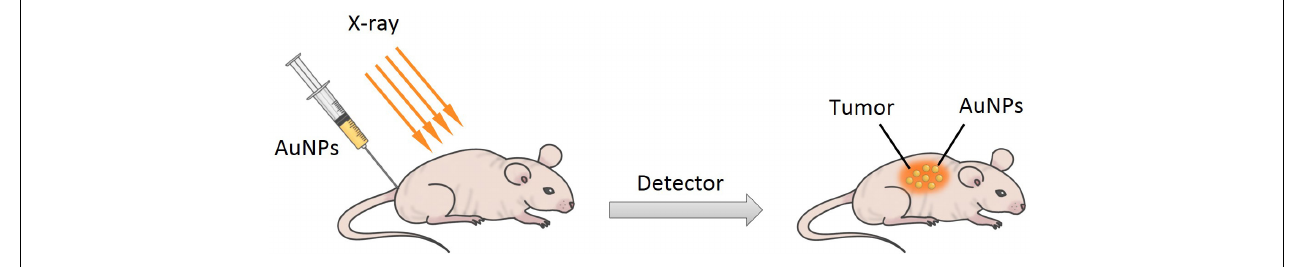
FIGURE 12 | A simple scheme for X-ray